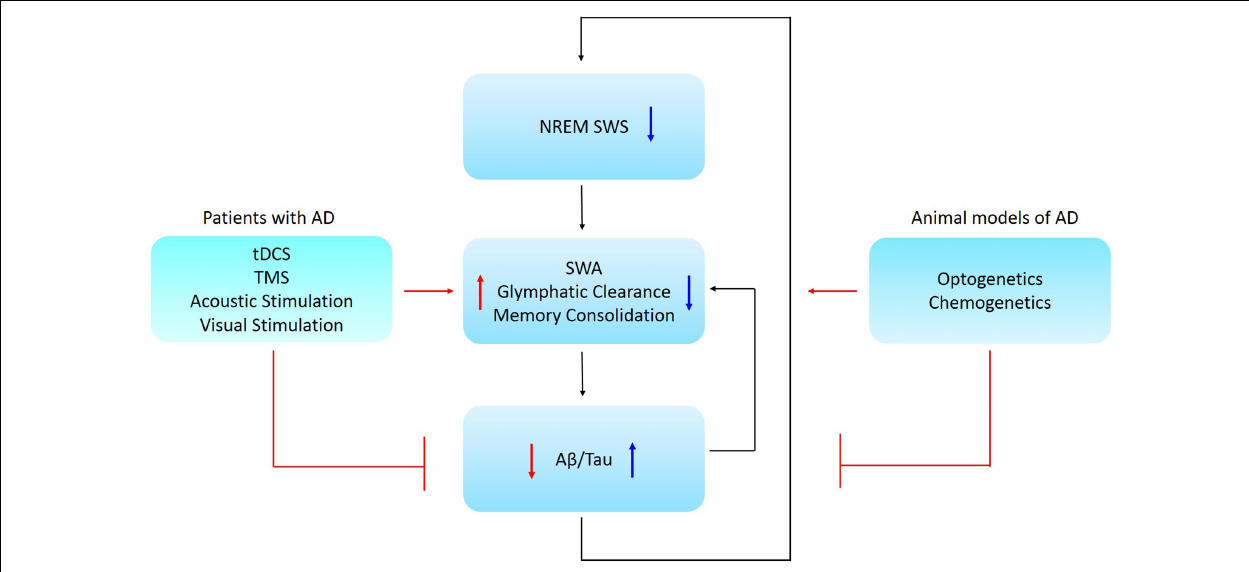
FIGURE 1 | Schematic representation of the causal relationship between NREM SWS, memory consolidation, and AD pathology. Low NREM SWS leads to reduced SWA and perivascular clearance of soluble A β and is associated with impaired memory consolidation. Further, low SWA is associated with increased A β /tau aggregation in AD patients. Ways to restore NREM SWA are proposed for animal models and Alzheimer’s patients, where these might lead to a promising therapeutic strategy for AD. Abbreviations: NREM SWS, non-rapid eye movement slow wave sleep; SWA, slow wave activity; A β , amyloid-beta; AD, Alzheimer’s disease; tDCS, transcranial direct current stimulation; TMS, transcranial magnetic